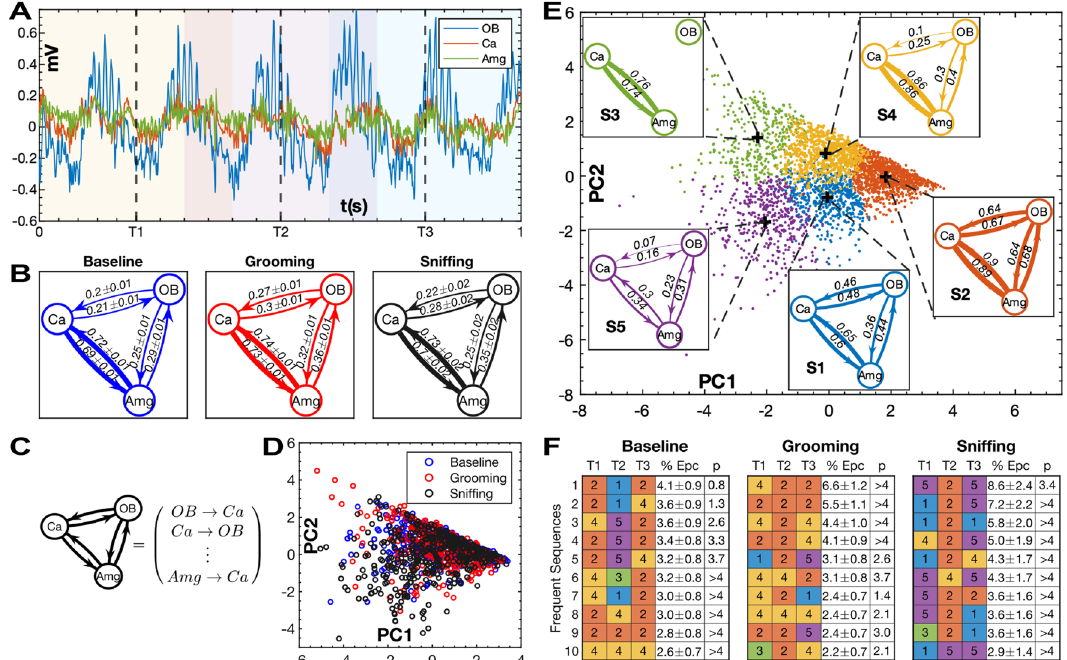
Figure 5. Application of CCS to multi-region neural recordings in rats. ( A ) Example LFP trace from a 1 s epoch. The blue, red, and green lines represent the signals from the Main Olfactory Bulb (OB), Hippocampus (Ca) and Amygdala (Amg), respectively. The time points, T1, T2, and T3 are the centers of 400 ms windows shown by the shaded regions of the plot. ( B ) Average 1 s CCS scores between the three regions